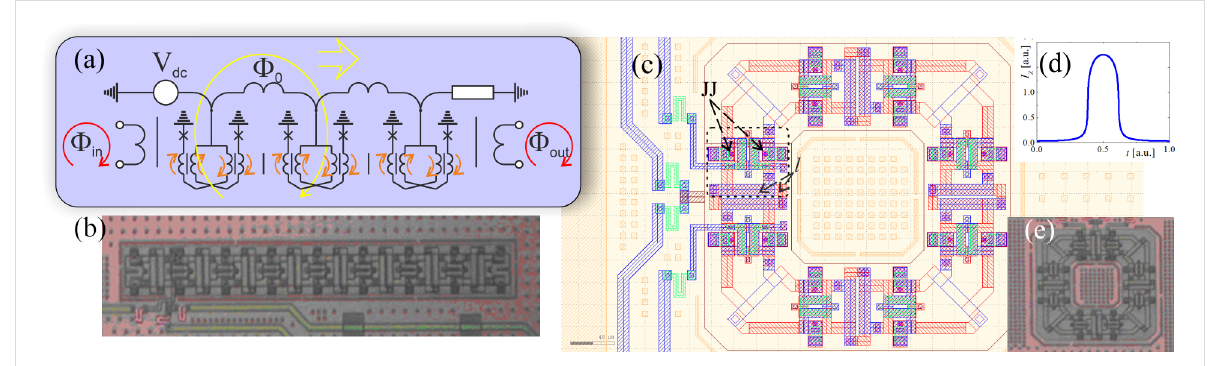
Figure 7: (a) A schematic diagram of a transmission line in ASL circuits, through which a soliton-like current wave can propagate, creating (from a qubit viewpoint) a control pulse of picosecond duration. Josephson junctions are depicted as crosses, the currents in the shoulder inductances are represented by short arrows. Linear (b) and circular (c, e) arrangement of elements in the experimental implementation for nSQUID-arrays manufac- tured by Hypres, as well as the numerically calculated current pulse in the system, the magnetic field of which affects the qubit (d). In the layout in ( с ), a separate ASL element is highlighted by a frame. Here, Josephson junctions and shoulder inductances are marked with “JJ” and “ l”